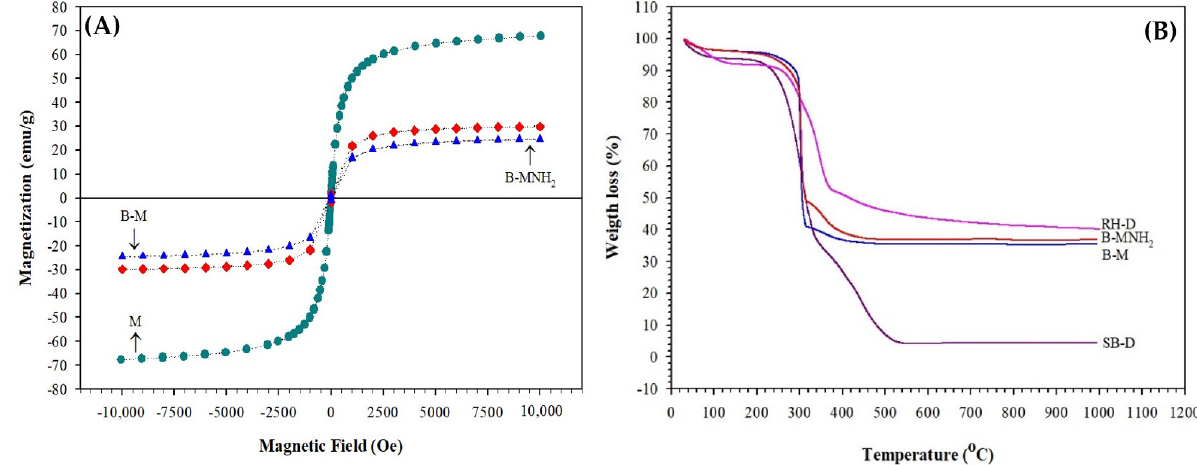
Figure 4. ( A ) Magnetization properties of naked amine magnetic nanoparticles (M), magnetic biocomposite (B-M), and amine magnetic biocomposite (B-MHN 2 ) at room temperature; ( B ) TGA analysis of delignified rice husk (RH-D), delignified sugarcane bagasse (SB-D), magnetic biocomposite (B-M), and amine magnetic biocomposite (B-MNH 2 ).